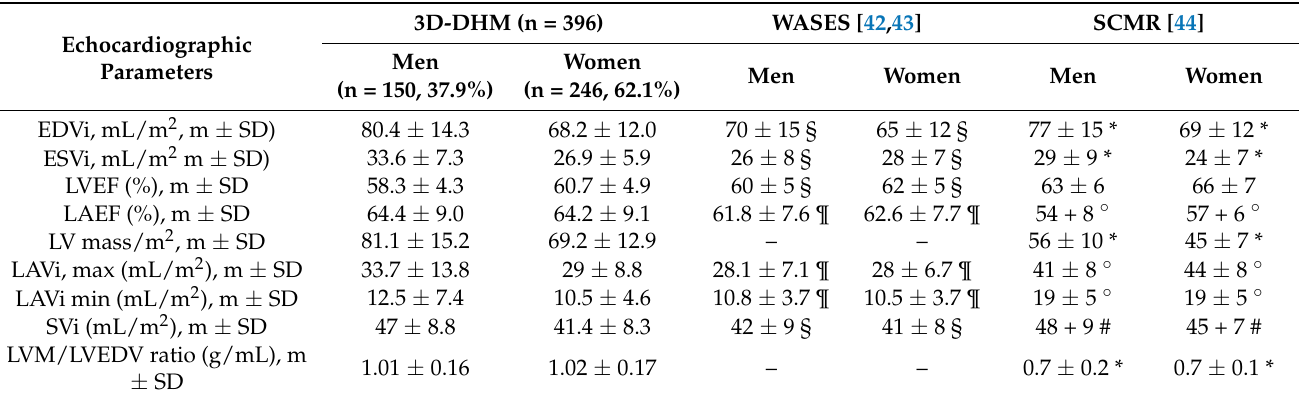
Table 3. Three-dimensional (3D)-DHM echocardiographic metrics in healthy subjects stratified according to sex compared to WASES and SCMR reference